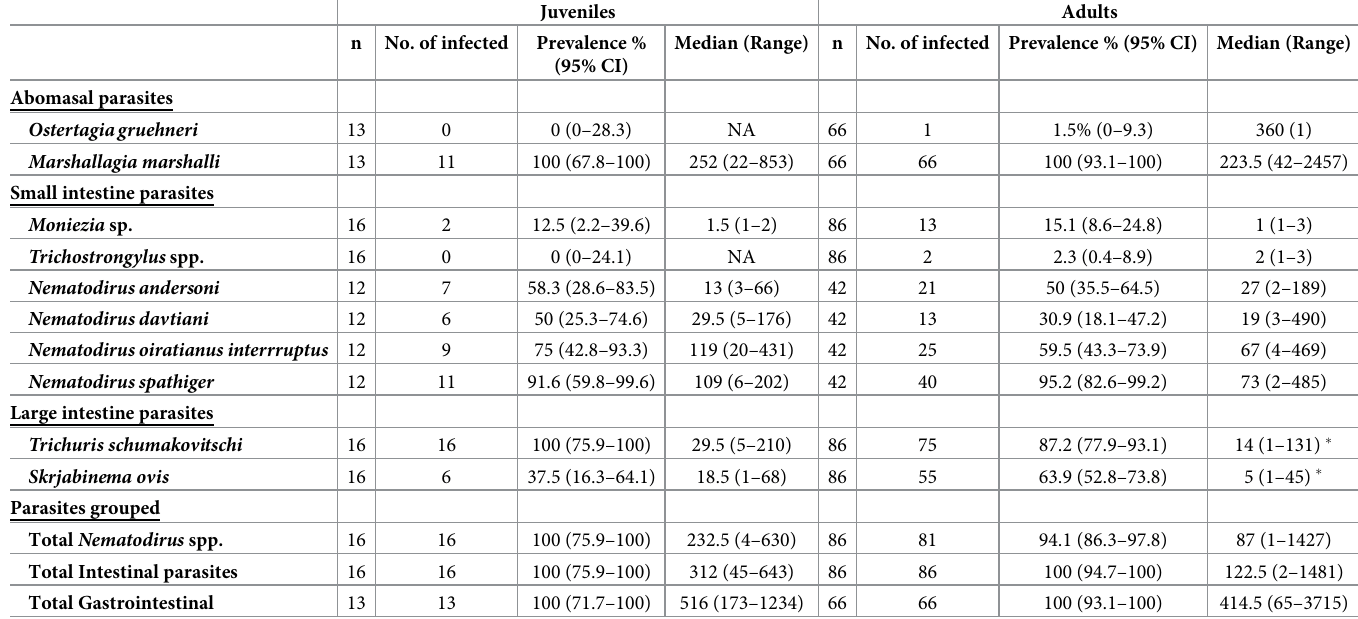
Table 1. Prevalence and median infection intensity of gastrointestinal helminths in Dall´s sheep categorized as Juveniles (sheep younger than 24 months, including two lambs younger than 12 months) and adults (sheep 24 months and older).